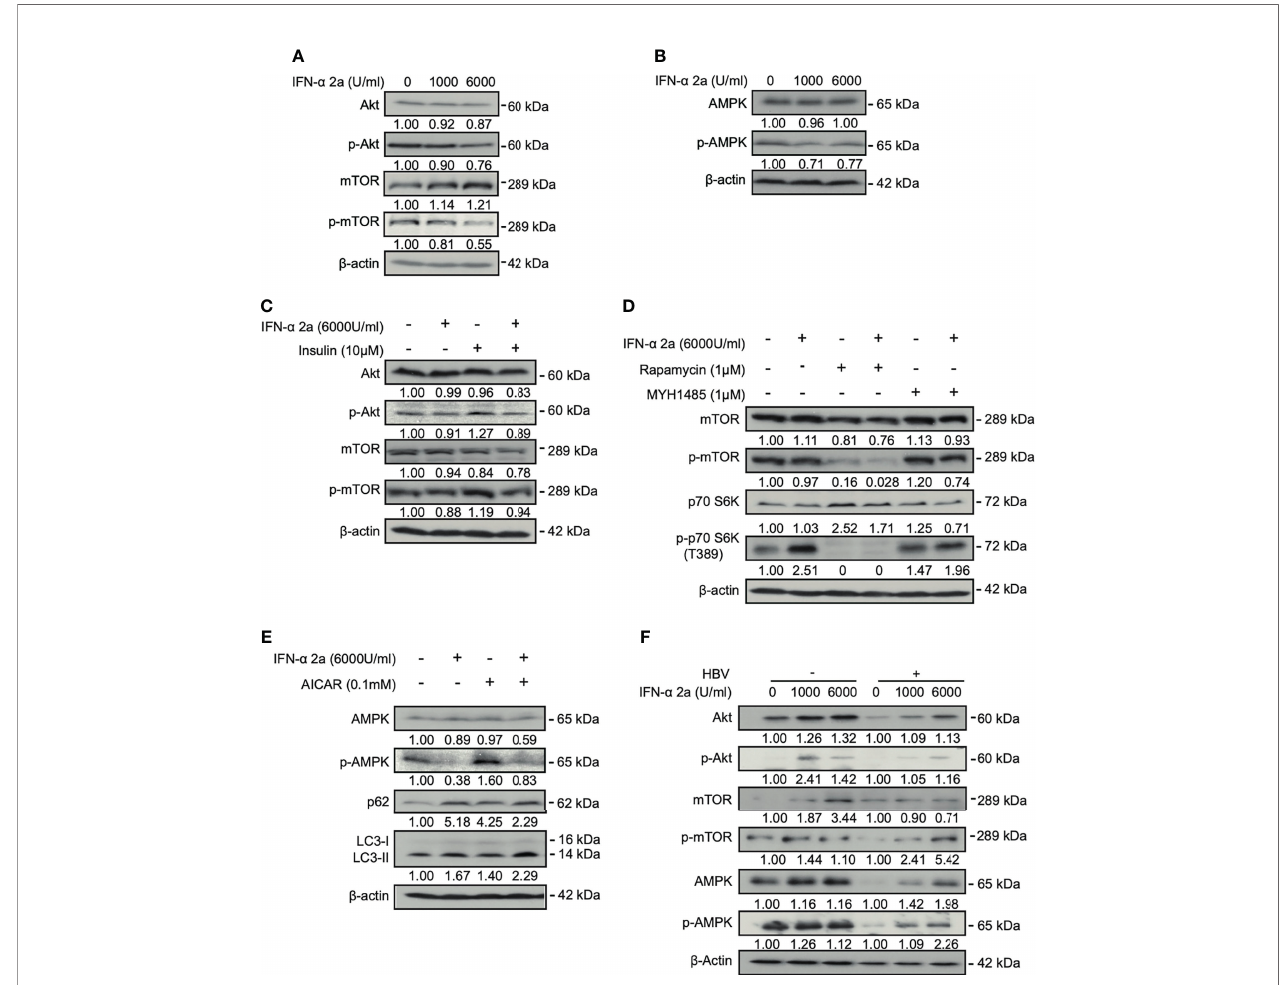
FIGURE 1 | IFN a -2a interferes with intracellular signal crosstalk. (A, B) HepG2.2.15 cells were treated with the indicated concentrations of IFN a -2a and harvested after 48 h. The total and phosphorylated Akt, mTOR, and AMPK were detected by western blotting and their relative levels were determined by quantifying the gray scales of bands, using beta ‐ actin as a loading control. (C) HepG2.2.15 cells were treated with 6000 U/ml IFN a -2a in combination with 10 m M insulin for 48 hr. The total and phosphorylated Akt, and mTOR were detected by western blotting and their relative levels were determined by quantifying the gray scales of bands, using beta ‐ actin as a loading control. (D) HepG2.2.15 cells were treated with 6000 U/ml IFN a -2a with or without 1 m M MTOR inhibitor rapamycin or activator MHY1485 for 48 h The total and phosphorylated mTOR and p-p70 S6K were detected by western blotting and their relative levels were determined by quantifying the gray scales of bands, using beta ‐ actin as a loading control. (E) HepG2.2.15 cells were treated with 6000 U/ml IFN a -2a with or without AMPK activator 0.1 mM AICAR for 48 hr. AMPK, phosphorylated AMPK, p62 and LC3 were analyzed by western blotting, using beta ‐ actin as a loading control. (F) PHHs were infected with HBV virions (multiplicity of infection = 30). 4 days post infection, PHHs were treated with IFN a -2a twice (1000 U/ml and 6000 U/ml). After 48 hr, The total and phosphorylated Akt, mTOR, and AMPK were detected by western blotting and their relative levels were determined by quantifying the gray scales of bands, using beta ‐ actin as a loading